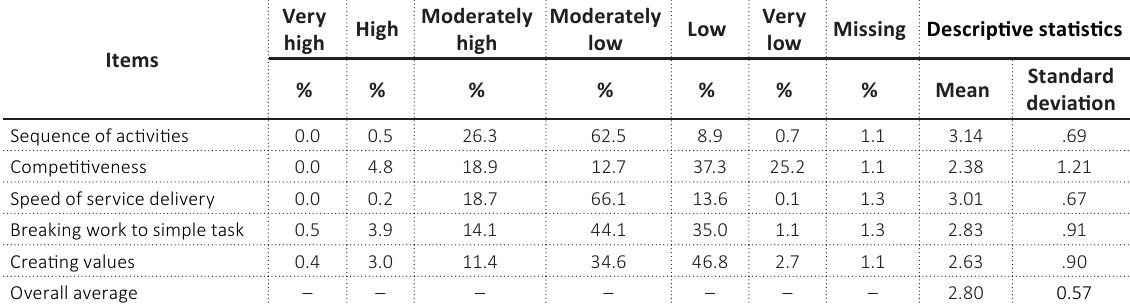
Source: Field survey result